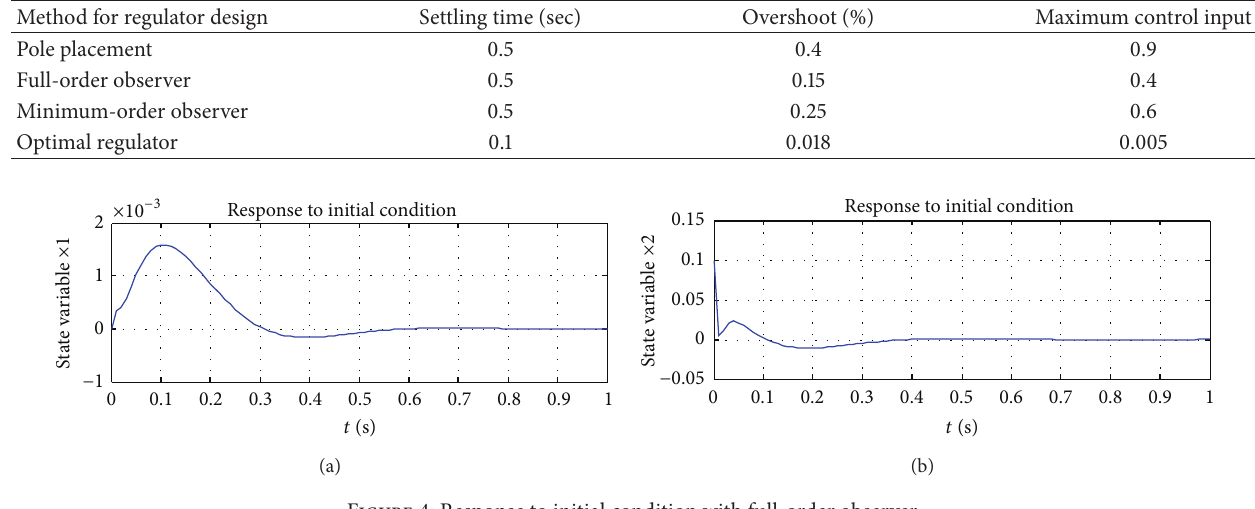
Figure 4: Response to initial condition with full-order observer.